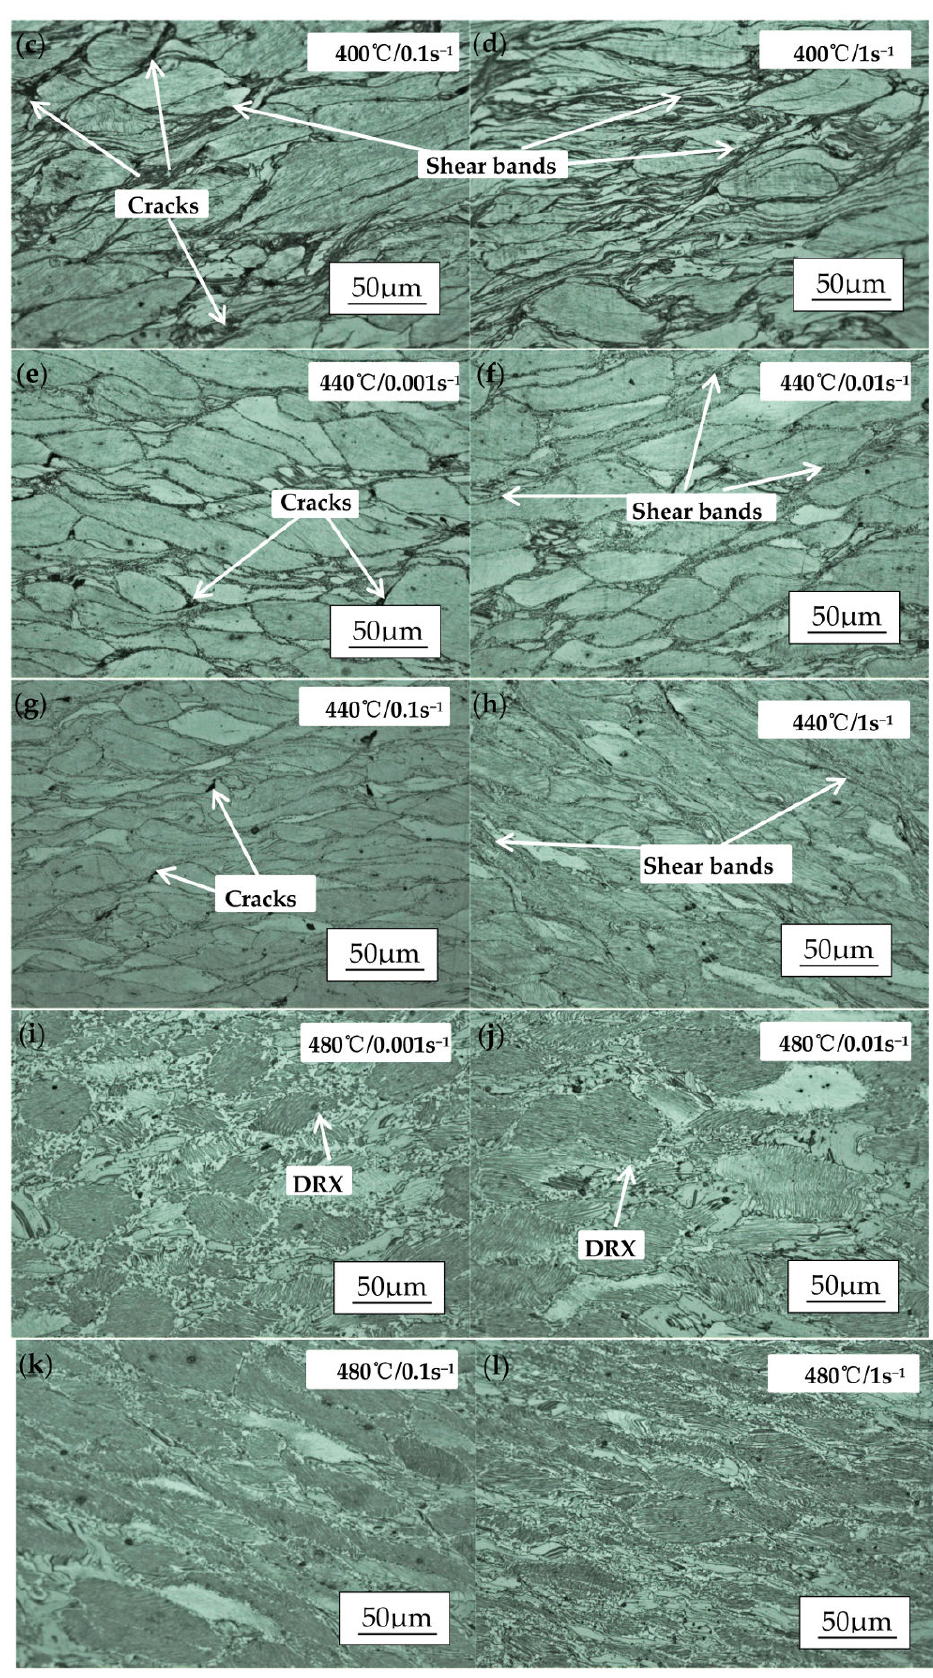
Figure 11. Micrographs of Mg-13.5Gd-3.2Y-2.3Zn-0.5Zr alloy compressed at 400 ◦ C, 440 ◦ C and 480 ◦ C at the strain rate of 0.001/s, 0.01/s, 0.1/s and